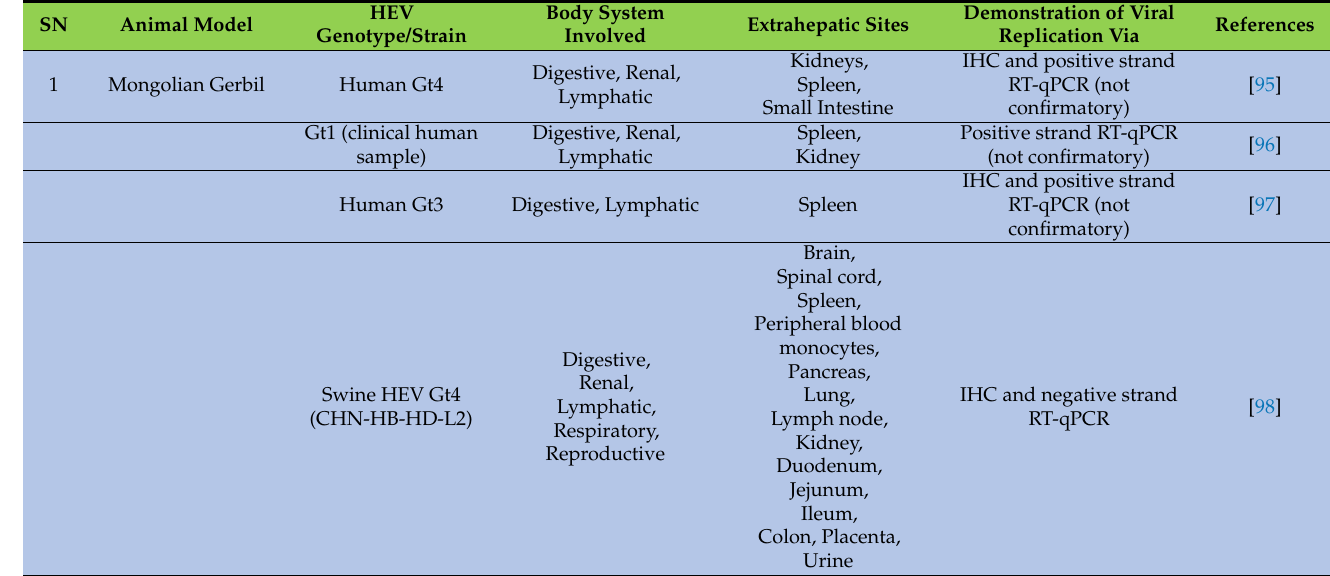
Table 5. List of animal models used to study HEV extrahepatic